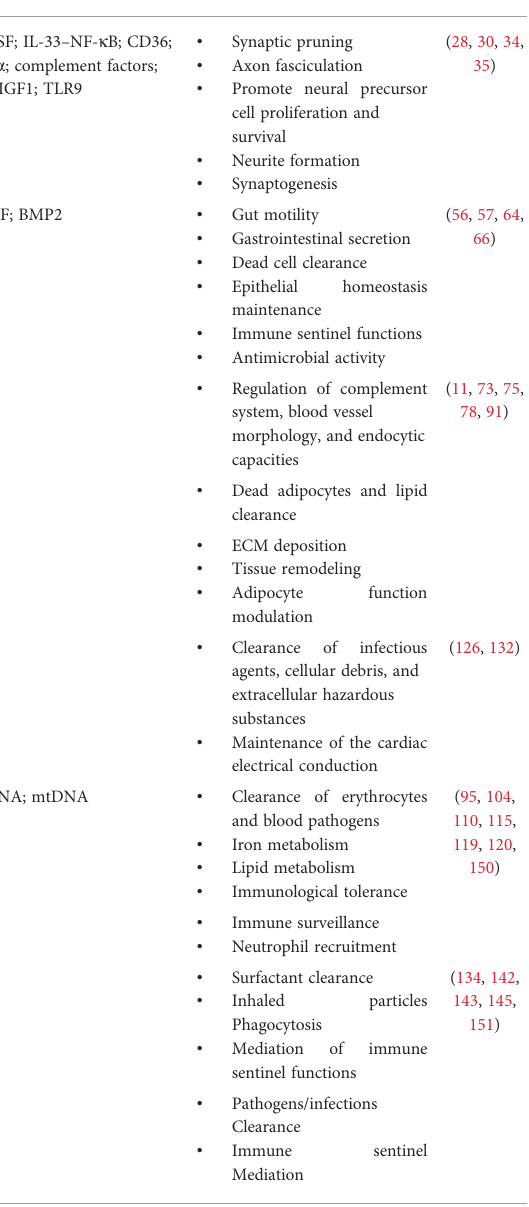
TABLE 1 The classi fi cation and function of the PC – TRM crosstalk in tissue homeostasis. Organ PC TRM Crosstalk signals Function